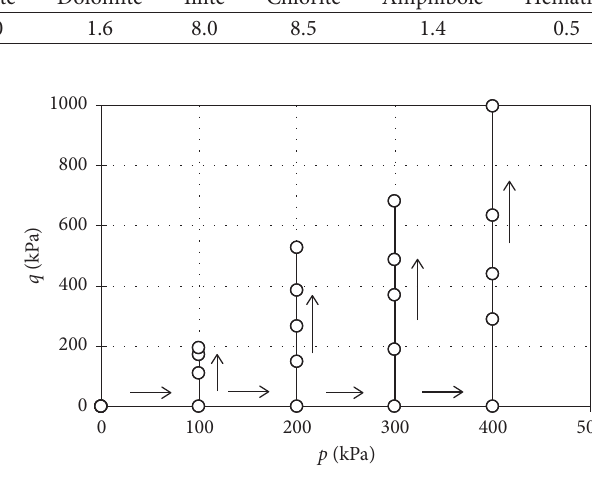
Figure 2: Stress paths of the triaxial tests on intact, compacted, and saturated loess specimens (each circle represents a stress state at which the PSD was